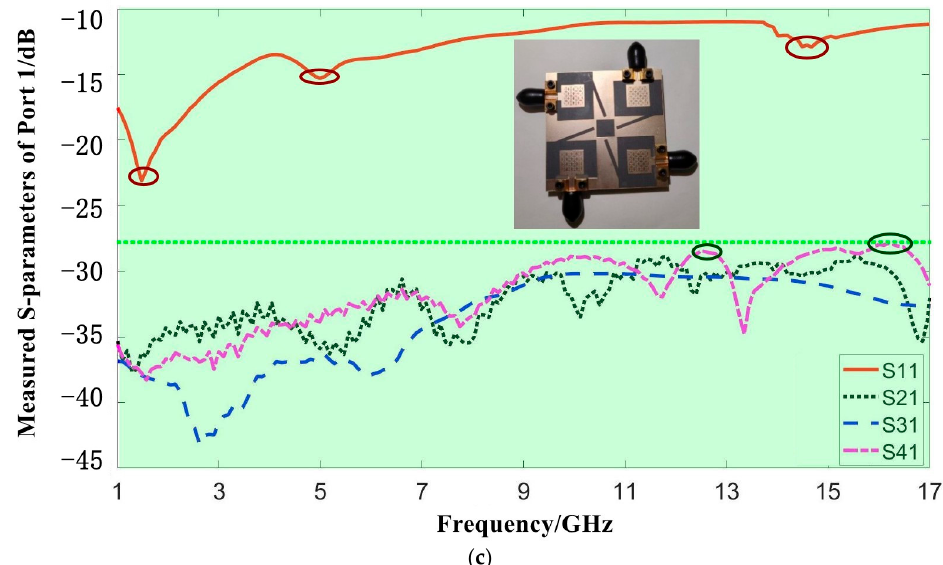
Figure 10. Reflection coefficient and transmission coefficient of UWB MIMO antenna at port 1: ( a ) simulation without introduced strips; ( b ) simulated results with strips; ( c ) measured results with strips.